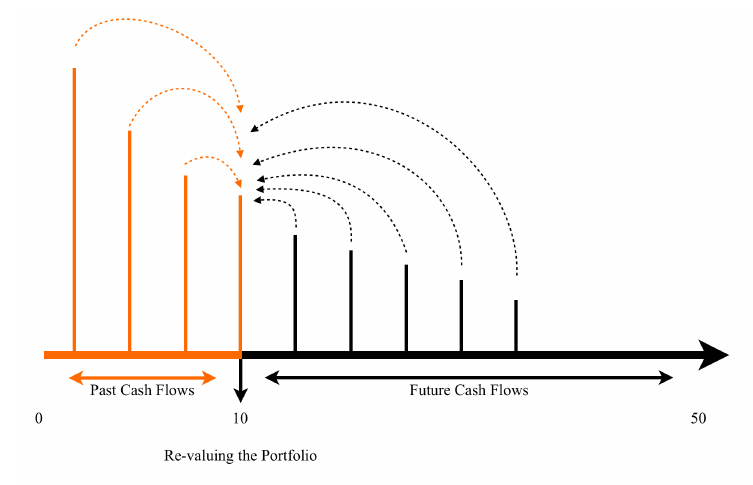
Figure 5. Illustration of Simulation for the Portfolio